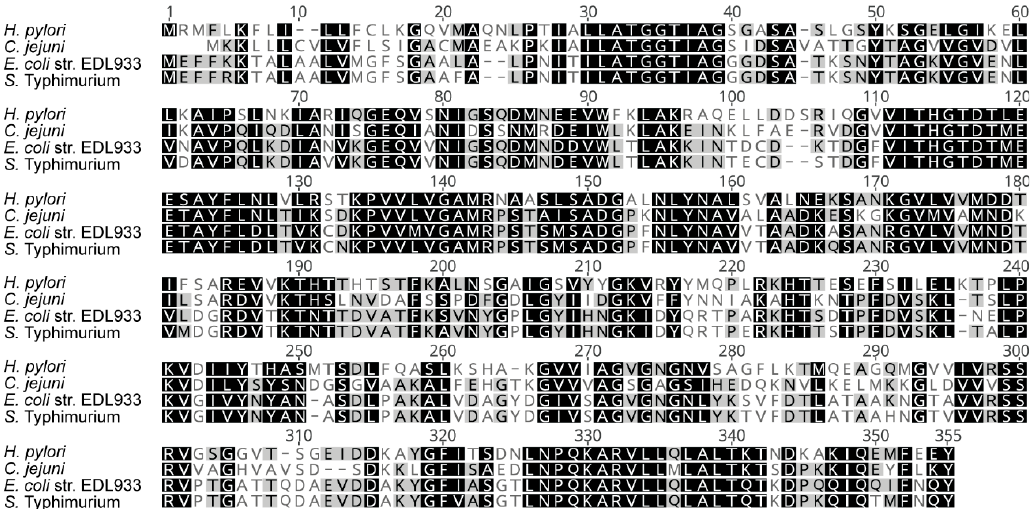
Figure 4. Amino acid sequence alignment of the L -asparaginase II homologues from different bacterial species. Alignment was performed using MUSCLE [54]. The accession numbers of the sequences used are AAG58088.1 (EDL933 strain), WP_128026528.1 ( Helicobacter pylori ), WP_084766606.1 ( Campylobacter jejuni ) and AAL21981.1 ( Salmonella